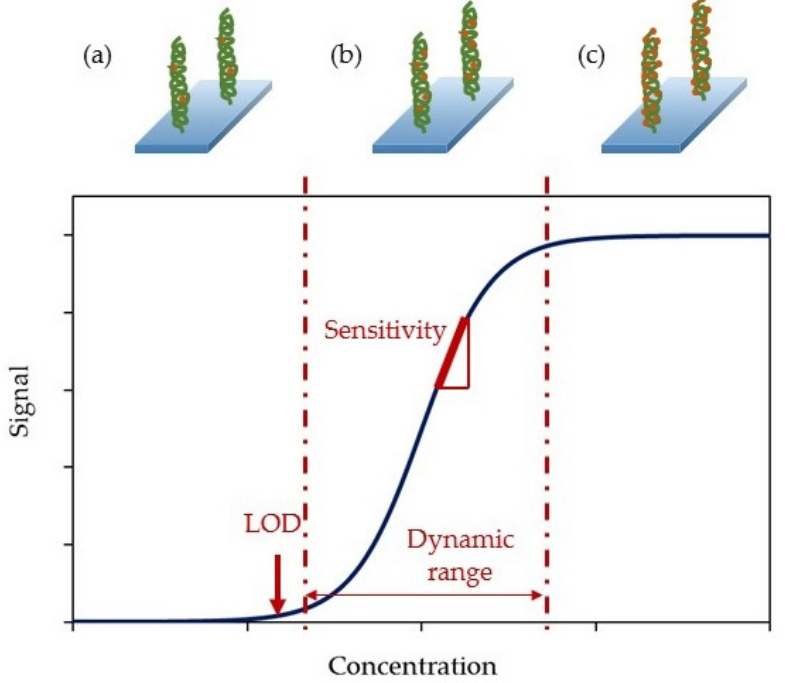
Figure 6. Sensitivity, limit of detection and dynamic range of a calibration curve. ( a ) The LOD is the minimum detectable concentration of the analyte, ( b ) the dynamic range is limited by the LOQ and the upper limit and ( c ) over the upper limit, the bioreceptor is saturated and it is not capable of detecting higher concentrations of the analyte.